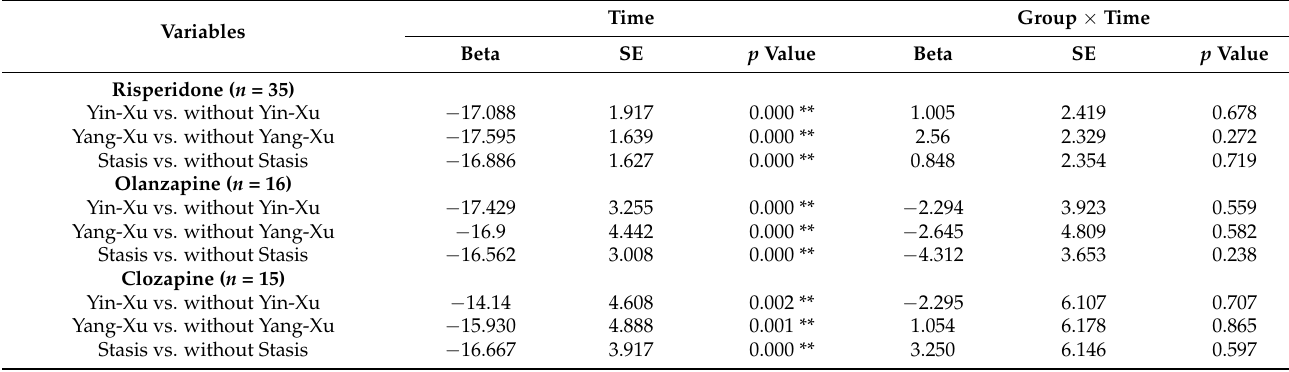
Table 5. General estimating equation for comparison of PANSS-T between different BC types within each SGA treatment group within the study’s time